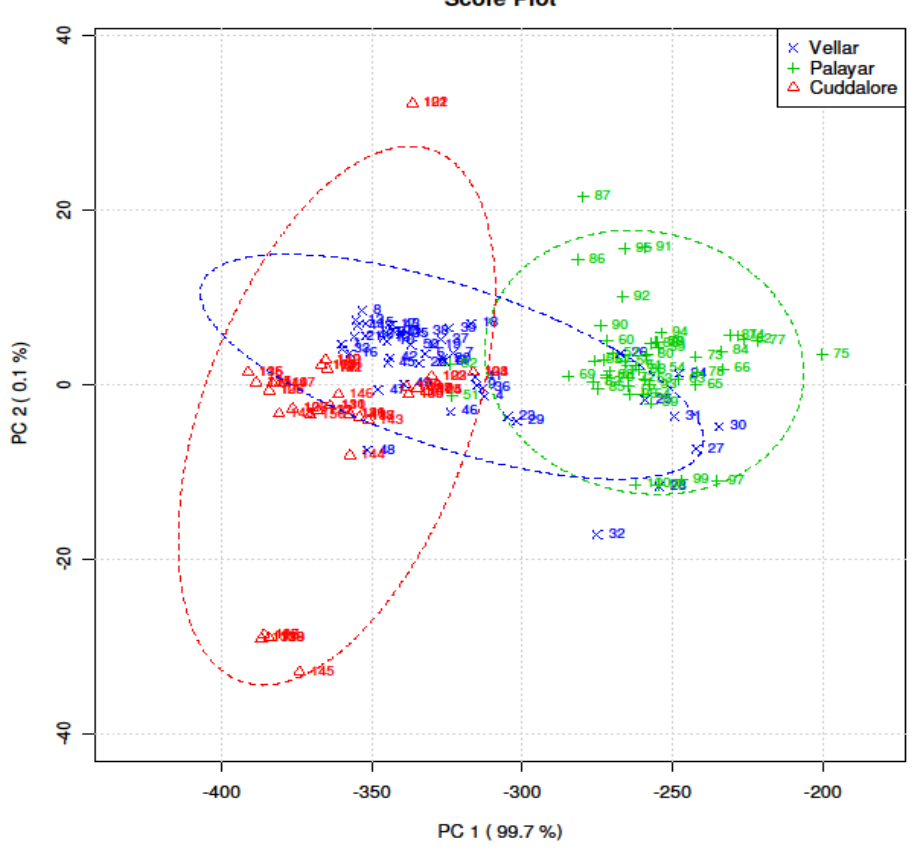
Fig. 2. Principal component score plot of morphometric data in three